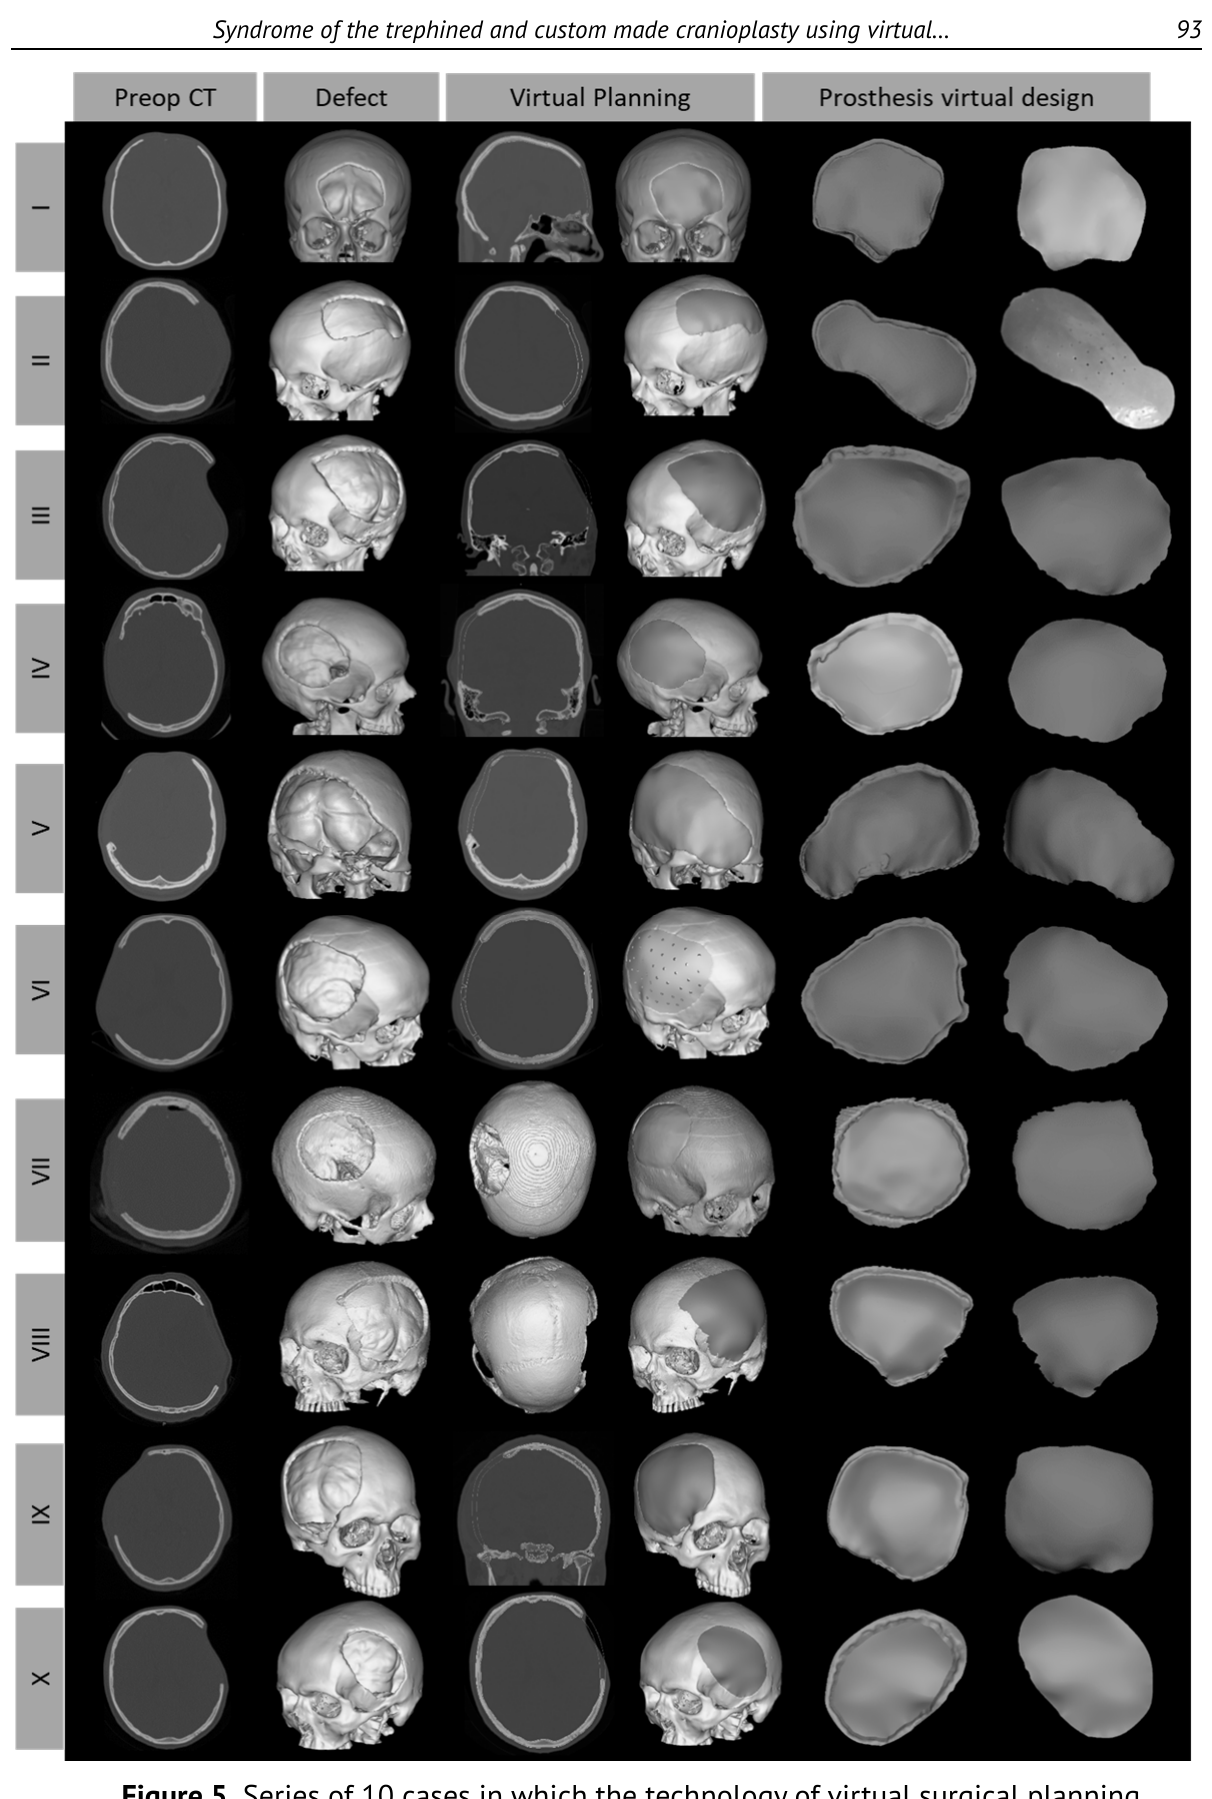
Figure 5. Series of 10 cases in which the technology of virtual surgical planning was